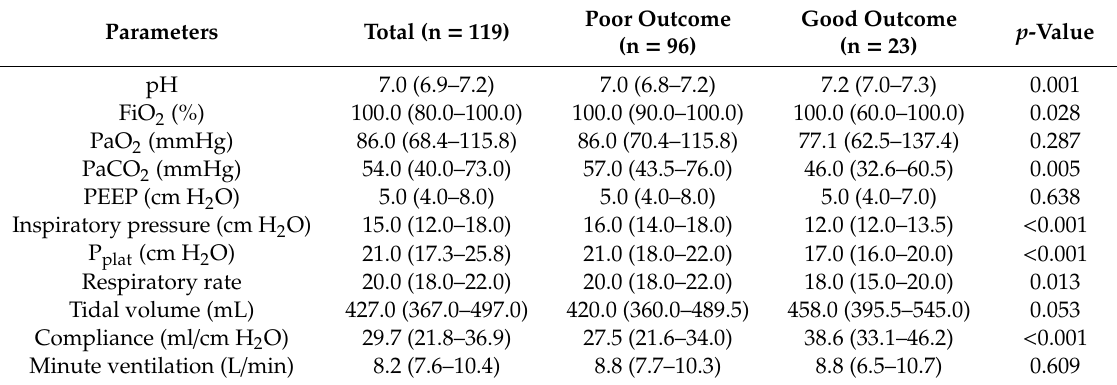
Table 2. Comparisons of ABGA and mechanical ventilator parameters on admission in the ARDS patients.